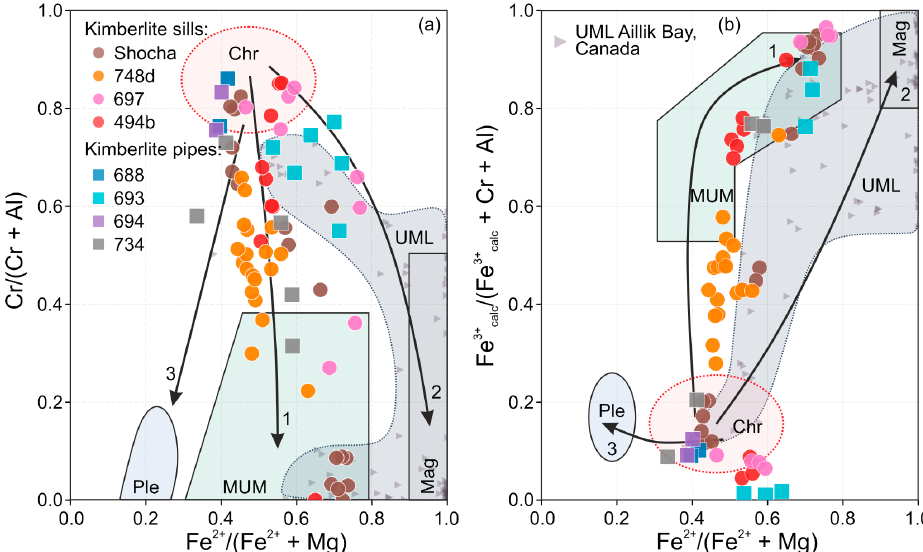
Figure 9. Cr/(Cr + Al) vs. Fe 2+ /(Fe 2+ + Mg) ( a ) and Fe 3+ /(Fe 3+ + Al + Cr) vs. Fe 2+ /(Fe 2+ + Mg) ( b ) variations of spinel grains from the Kepino kimberlites. Discrimination fields and magmatic evolution trends are from [62]: trend 1 indicates transitional spinel composition from chromite (Chr) to the solid solution of magnesian ulvöspinel, ulvöspinel, and magnetite (MUM); trend 2 indicates transitional spinel composition from chromite to magnetite (Mag); trend 3 indicates transitional spinel composition from chromite to pleonaste (Ple). Most of the spinel grains follow magmatic evolution trend 1. The composition of the studied spinel partly overlaps the composition of spinel from UML Aillik Bay, Canada, based on [59].